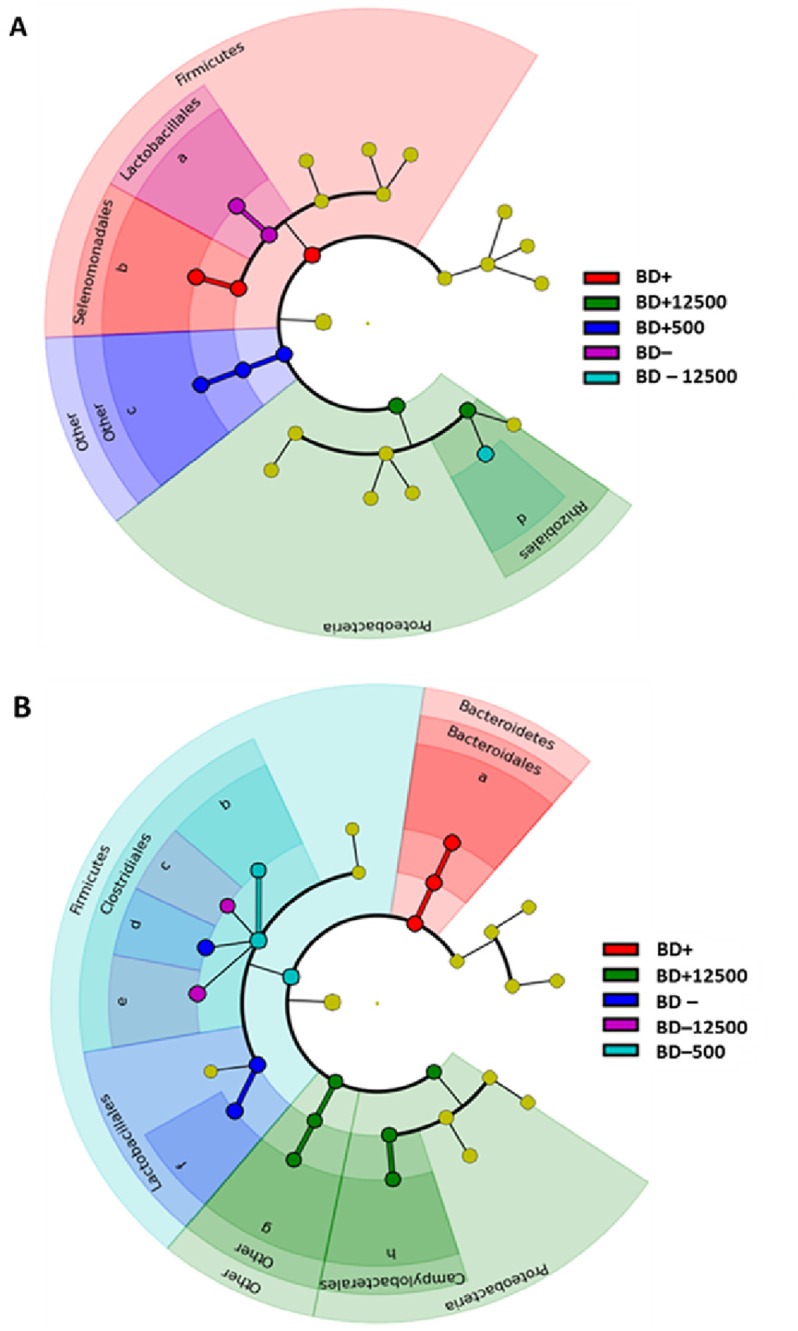
Dietary effect on phylogenetic composition of the chicken´s crop (A) and cecal (B) microbiome.Cladograms of both sections show a comparative evaluation of the experimental treatments effects on the structure of the chicken´s GIT microbiome. Effects are calculated through LDA Effect Size [53], a two-module algorithm. In the first module, technical triplicates of each dietary group (n = 2) were subjected to non-parametric Kruskal-Wallis test to detect features with significant differential abundance with respect to the experimental treatments. In the second module, tabular abundance data formatted in the previous module are subjected to Linear Discriminant Analysis [21] to estimate the effect size of each differentially abundant feature. The only diets and bacterial families showing statistical significance (p<0.05) in the previous statistical tests are visualized in the figures. Yellow dots refer to bacterial specimens whose protein pattern and abundance did not score a statistical significant effect (p>0.05) in any of the experimental diets. Bacterial families legend: (A) a: Lactobacillaceae; b: Veillonellaceae; c: Other families; d: Bradyrhizobiaceae. (B) a: Bacteroidaceae; b: Clostridiaceae; c: Eubacteriaceae; d: Lachnospiraceae; e: Ruminococcaceae; f: Lactobacillaceae; g: Other families; h: Helicobacteraceae.